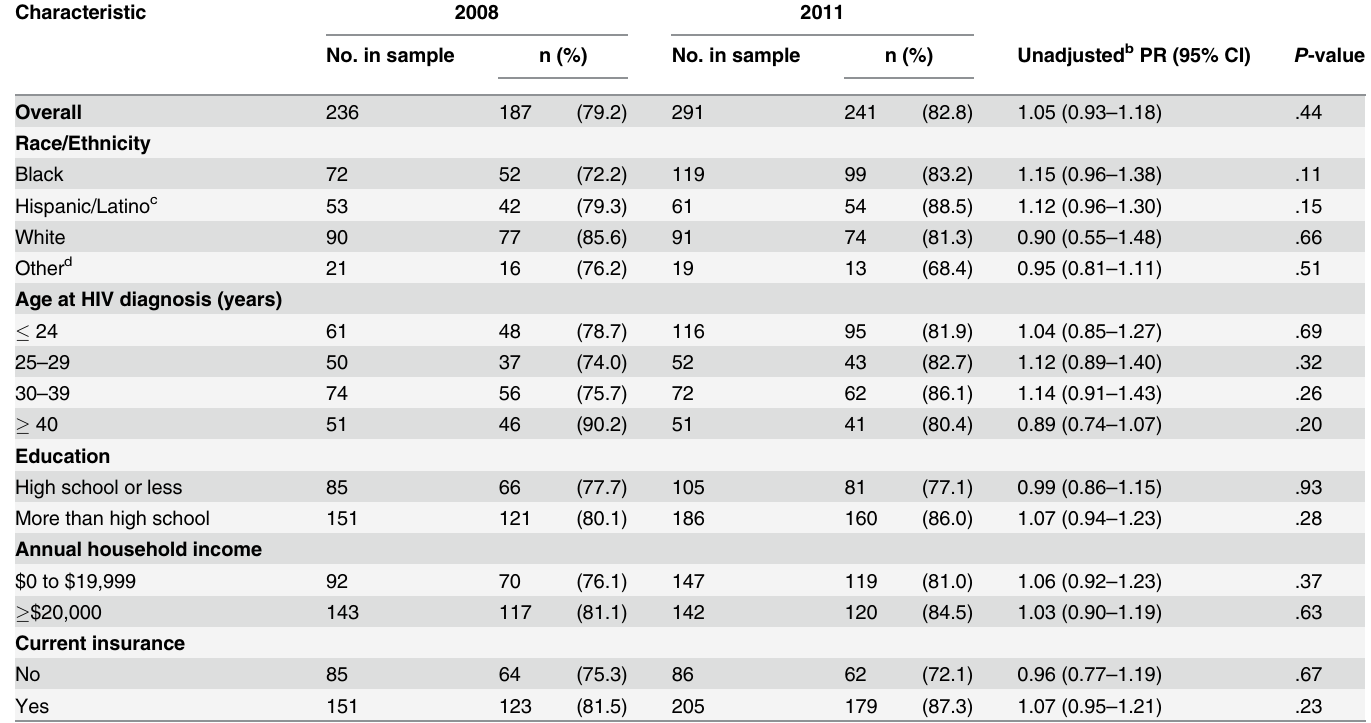
Table 3. Prevalence of early linkage to HIV care and prevalence ratios comparing prevalence of early linkage to care a in 2011 to 2008 among men who have sex with men – NHBS.